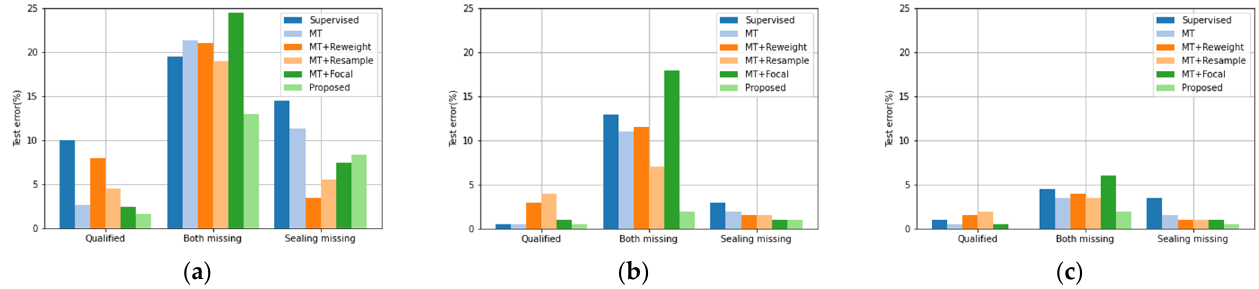
Figure 8. Test error rates from experiments under three percentages of labeled data: ( a ) .